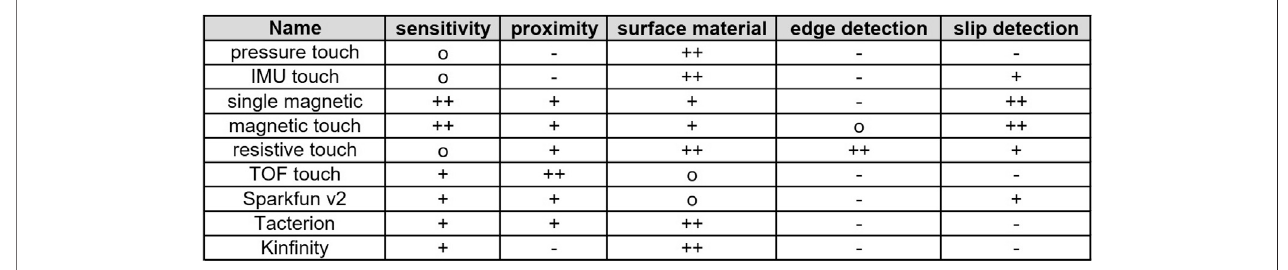
FIGURE 11 | Summary of performance characteristics for all the tested sensors.